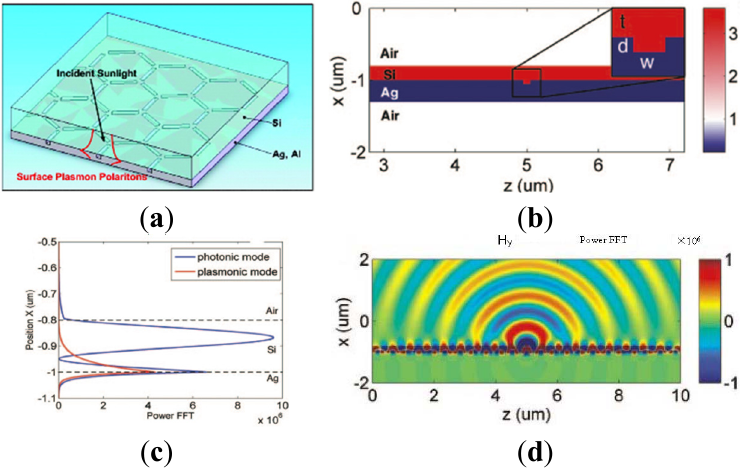
Figure 3. ( a ) A 3D conceptual schematic of a solar cell with subwavelength grooves tiled on a back Ag contact. ( b ) The schematic outline of the device layer in the simulation, with the inset of panel b defining the width and depth of a groove. ( c ) The modal profiles of the two identified modes, plotting power as a function of position in the waveguide. ( d ) The